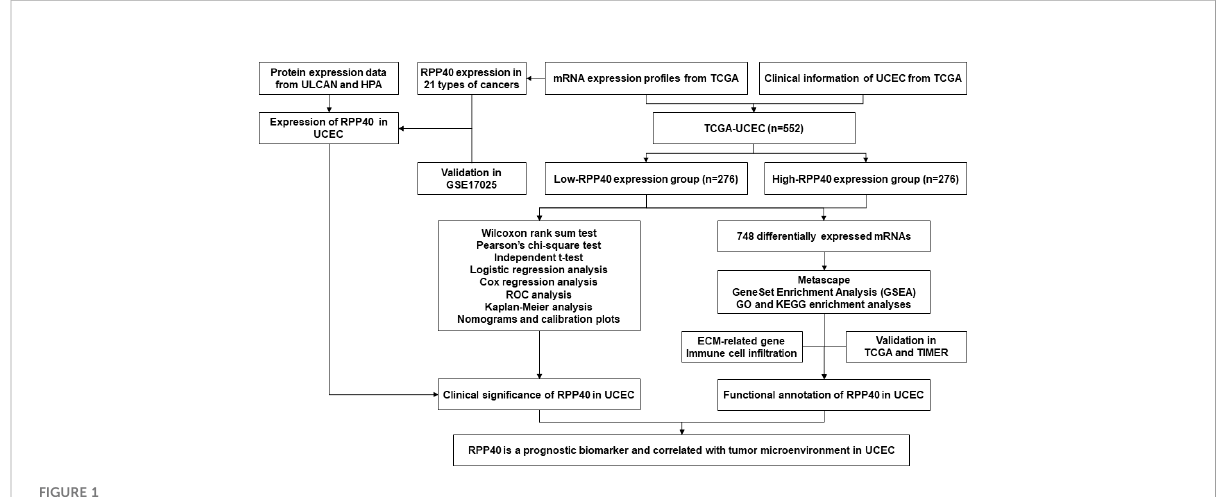
FIGURE 1 Flow diagram of this